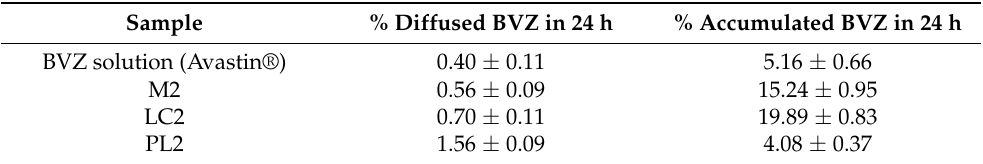
Table 7. Amount of permeated and accumulated BVZ after 24 h, expressed as a percentage, through the cornea, released from the ME systems under